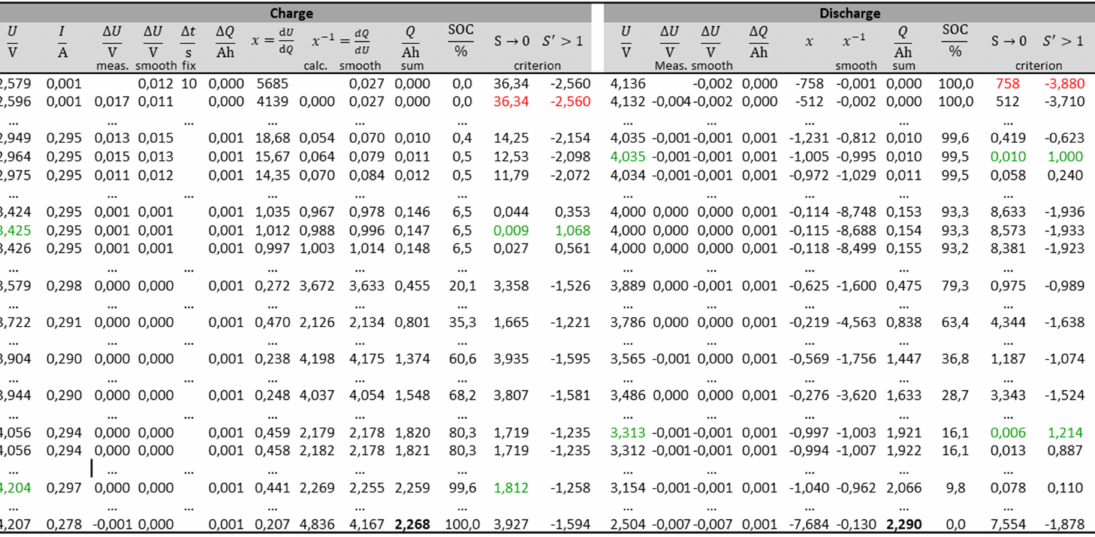
Figure 4. Calculation recipe for the intersection method. Example data from this work. The (cid:12) (cid:12) criterion S = (cid:12) → 0, or S (cid:48) = − lg ( 10 · S ) > 1 shows the cell voltage at the intersection (cid:12) x − x − 1 point, d Q /d U = d U /d Q ≈ 1, in the charge–discharge curve (below in green). Electric charge Q , available capacity Q 0 (in bold), and state-of-charge (SOC = Q / Q 0 ) are given for information only. In Figure 5, the intersection method was applied to lithium NCA batteries. Qualita- tively the same results were obtained as with the other cell chemistries. For NMC and NCA chemistries, the upper intercept around 4 V reflected “virtually full” (SOC > 99%).